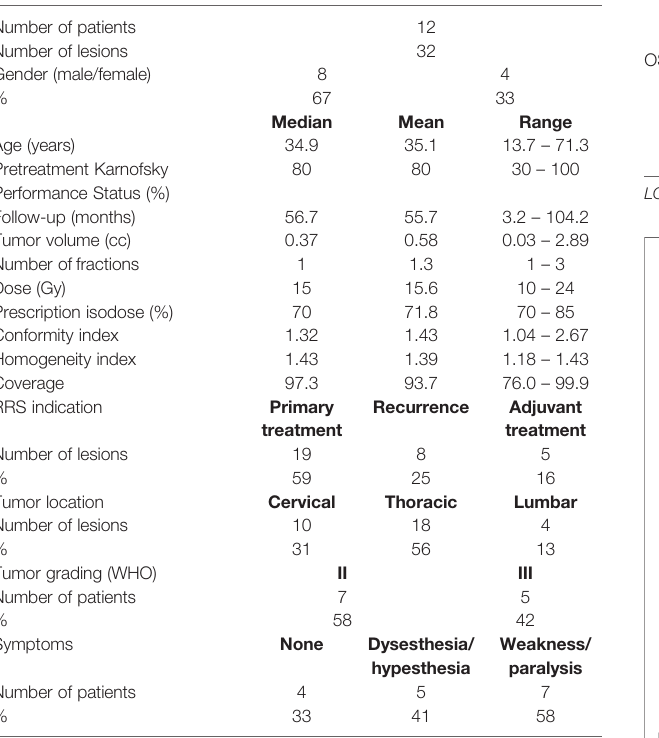
TABLE 1 | Patient and treatment characteristics.